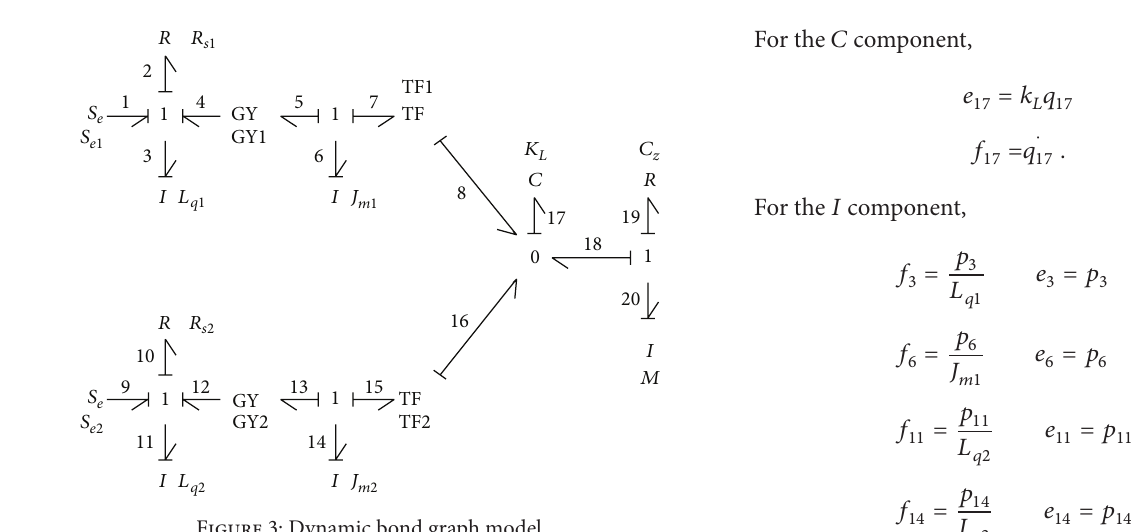
Figure 3: Dynamic bond graph